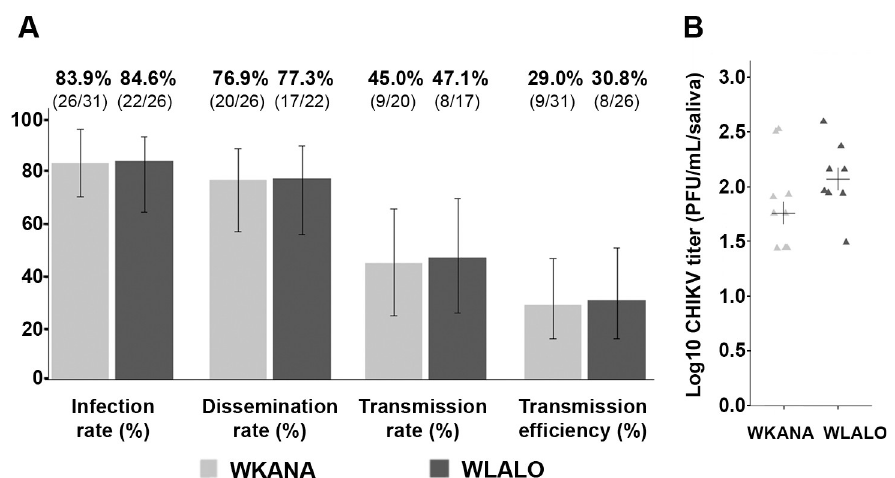
Fig 3. Experimental infections of Aedes polynesiensis mosquitoes from Wallis with CHIKV. (A) Infection rate, dissemination rate, transmission rate and transmission efficiency at 7 dpi for the two populations WKANA and WLALO. The percentage value and the number of positive females are indicated above each plot. (B) The titer of infectious saliva is expressed as PFU/mL/saliva for each of the 9 or 8 (for WKANA and WLALO populations, respectively) females whose saliva was tested positive. The cross indicates the median